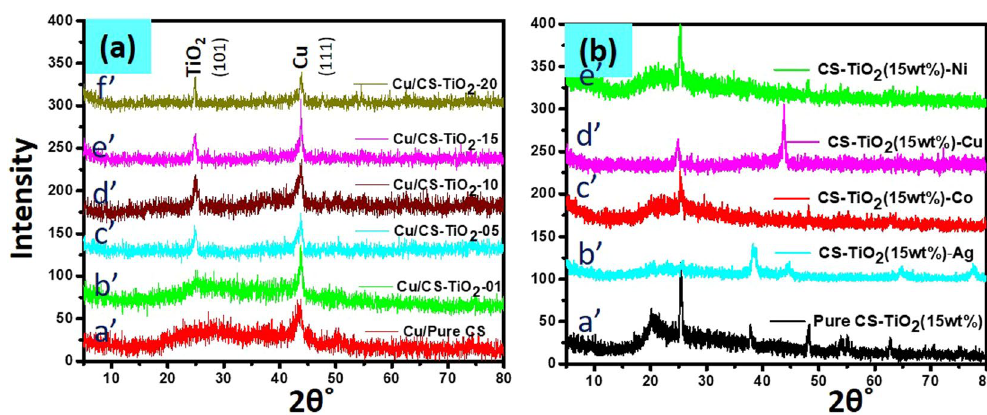
Figure 3. XRD pattern of nanocomposite fibers templated metal